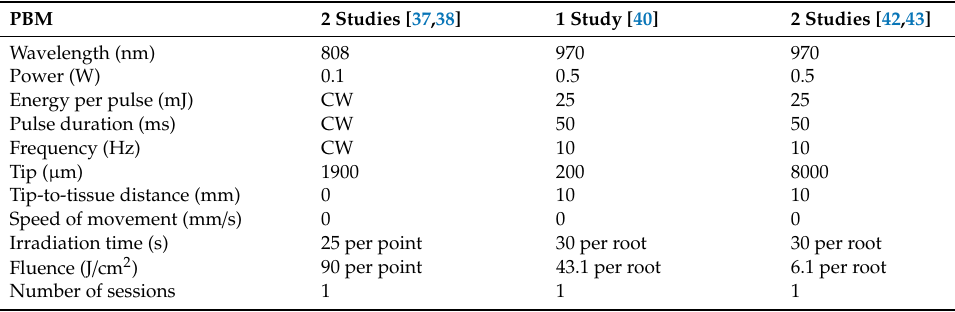
Table 7. Parameters used in PBM in